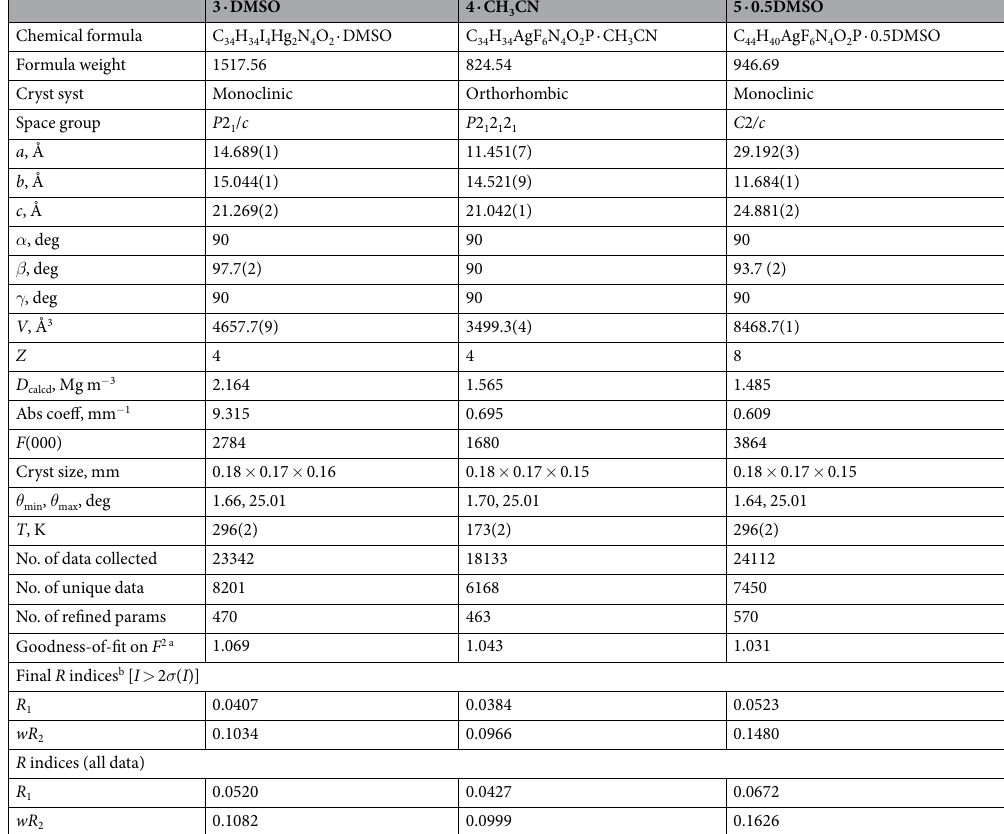
Table 2. Summary of crystalographic data for 3 – 5 . a GOF = [ Σ w(F o2 − F c2 ) 2 /( n − p )] 1/2 , where n is the